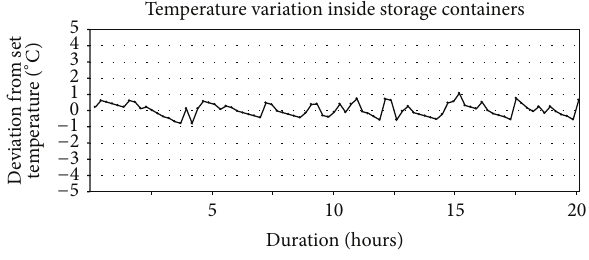
Figure 1: In a pilot study, the temperature inside seven of the storage containers was noted at 86 consecutive time points throughout 20 hours to assess the magnitude of the variation of the set temperature. The maximum deviation was − 0.8 to +1.0 ∘